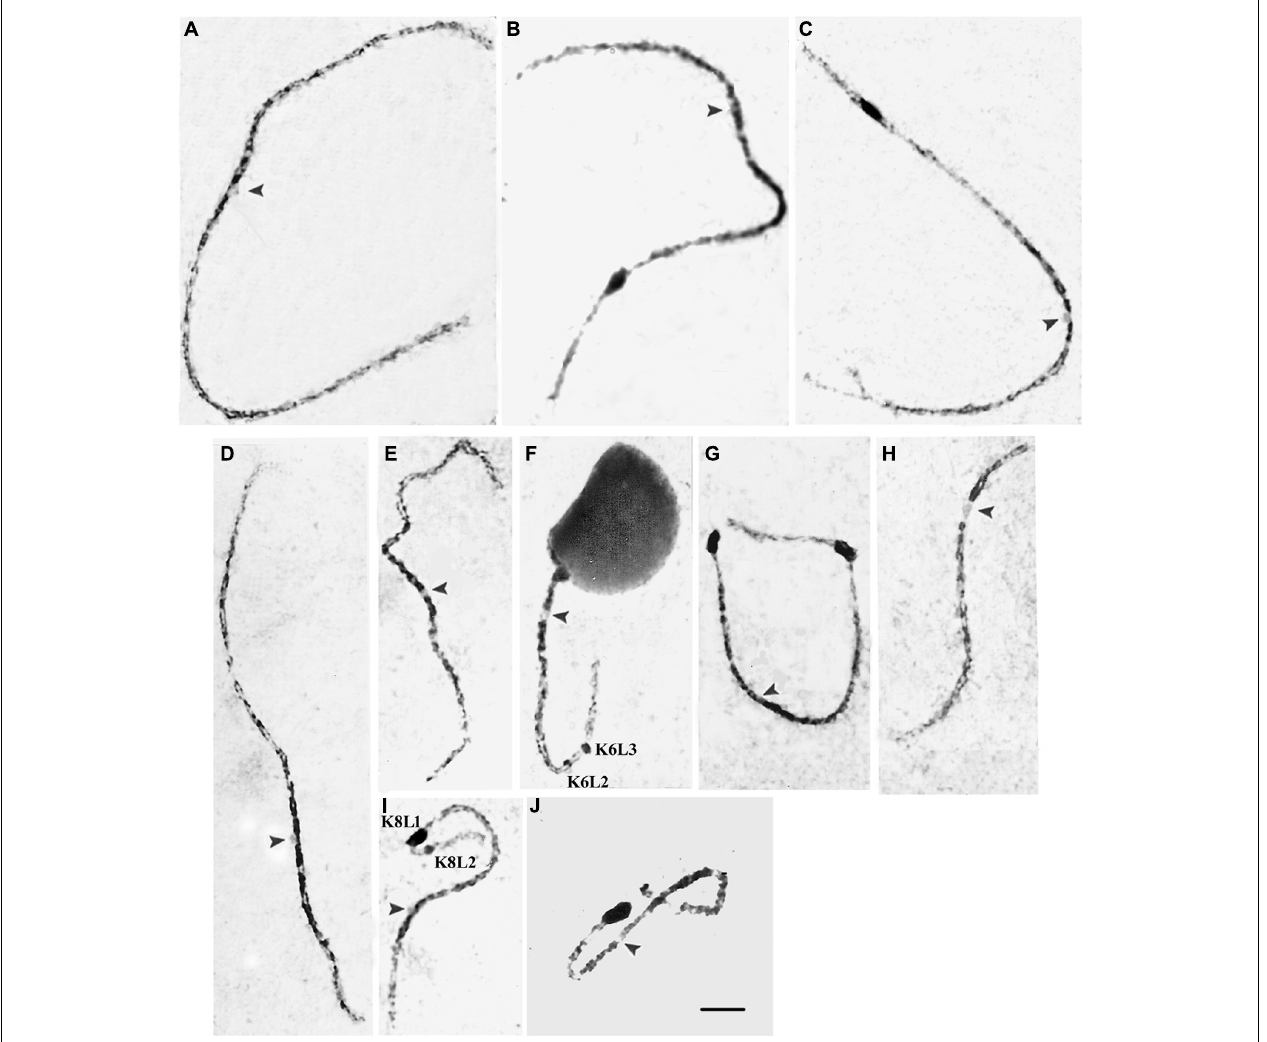
FIGURE 3 | Carmine-stained pachytene chromosomes of the 441123 × 444331 hybrid showing cytologically visible knobs on chromosomes 3(B), 5(C), 6(F), 7(G), 8(I), and 9(J). Chromosomes